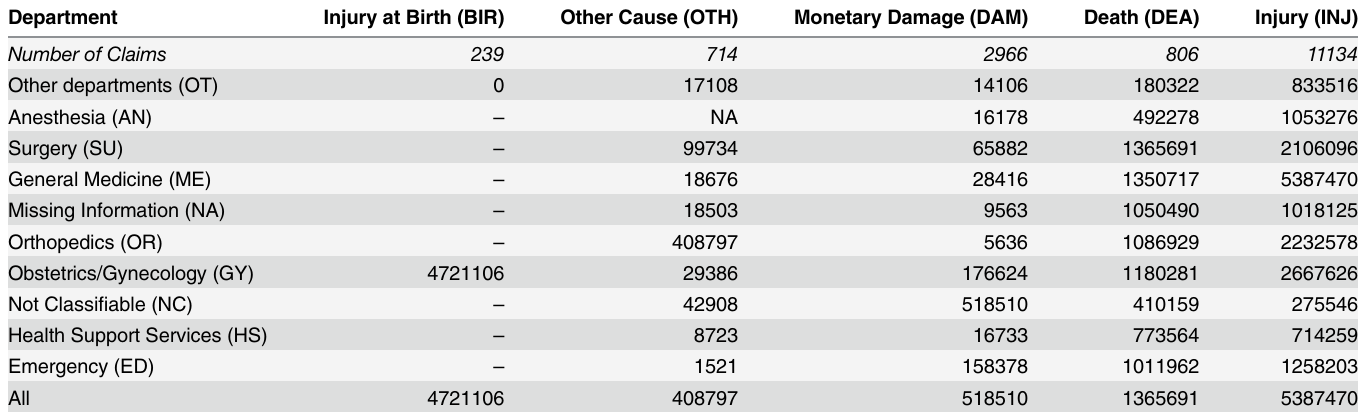
Table 4. Largest observed monetary amounts by alleged cause of claim and department.